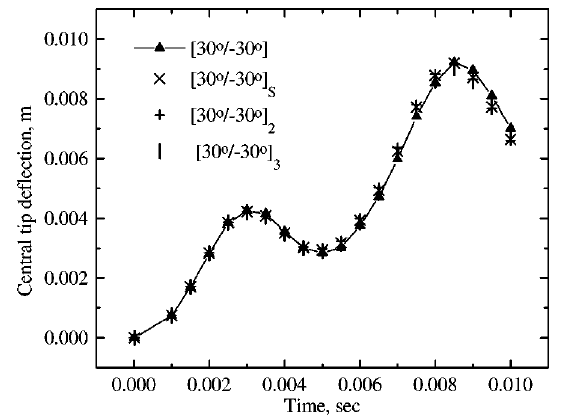
Fig. 8. Central tip deflection versus time for a cantilever single-fold folded plate with crank angle (cid:11) = 120 (cid:14) , subjected to suddenly ap- plied pulse loading (4 (cid:2) 3 mesh).